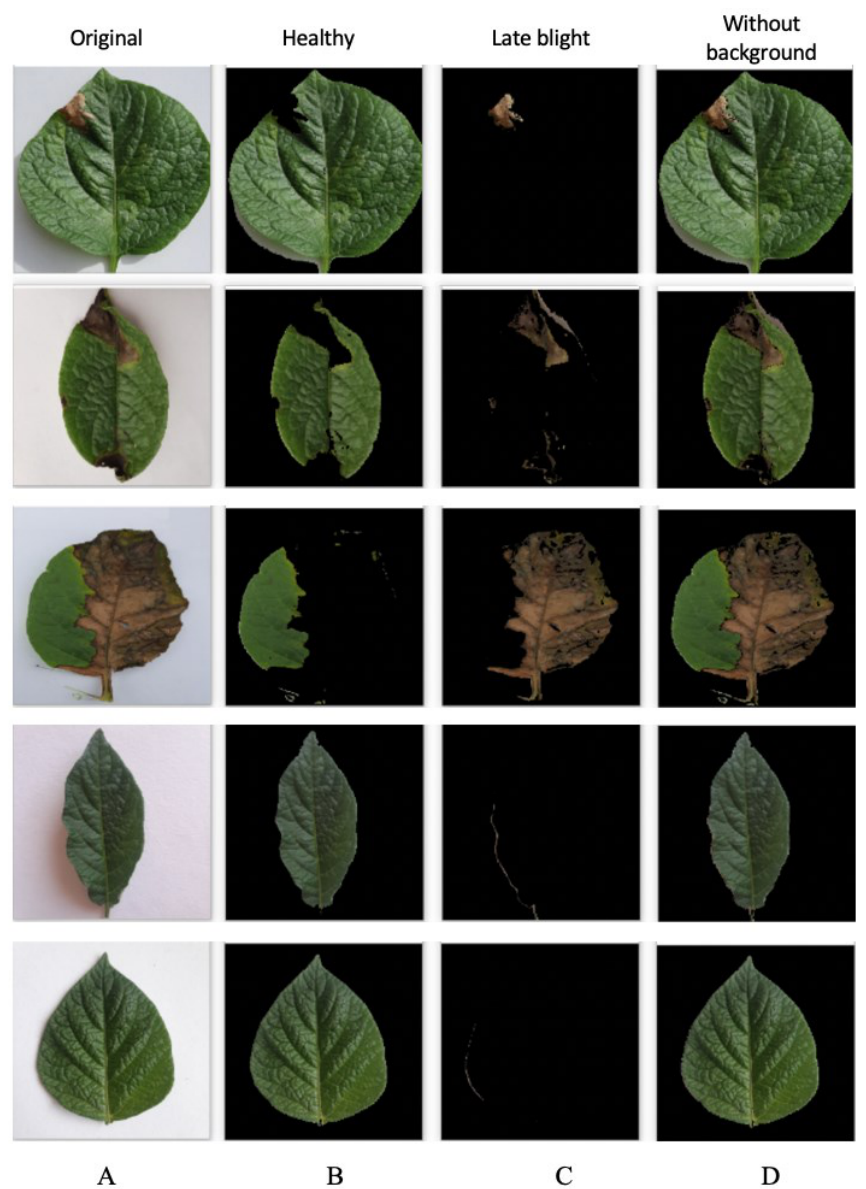
Figure 7. Result obtained from the application of Range Threshold Segmentation.